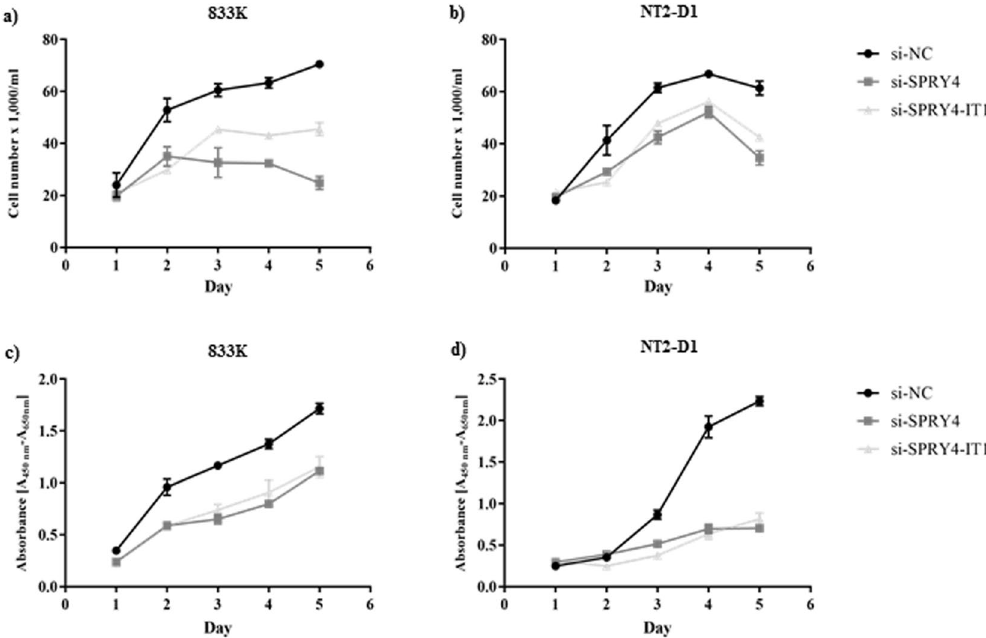
Figure 3. Cell counting and proliferation after knockdown of SPRY4 and SPRY4-IT1 . Knockdown of both SPRY4 and SPRY4-IT1 decreased the number of viable cells and the cell proliferation significantly both in 833 K ( a , c ) and NT2-D1 cells ( b , d ) in a time-dependent manner. The experiments were repeated at least three times, and a representative experiment is shown here. t -test: Control vs siRNA, mean ± SD, statistical significance p <